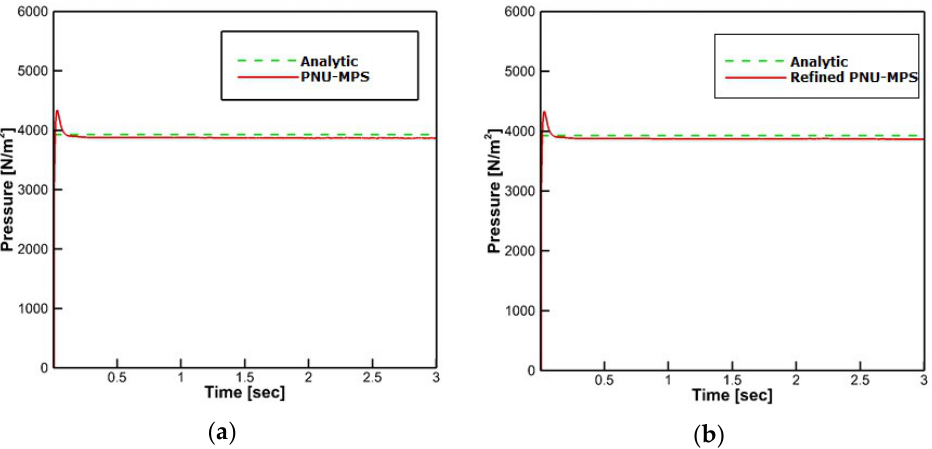
Figure 5. Time-histories of hydrostatic pressure proved at P1, which are simulated by the ( a ) PNU-MPS and ( b ) present refined PNU-MPS adopting the staggered divergence-free model and the